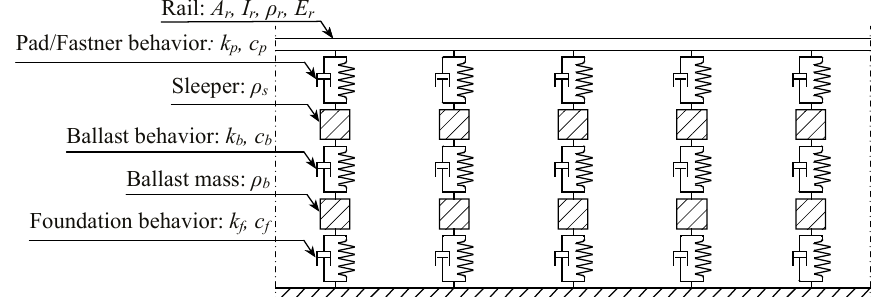
Figure 2. Railway track modeling. Table 3. Mechanical properties of the track.